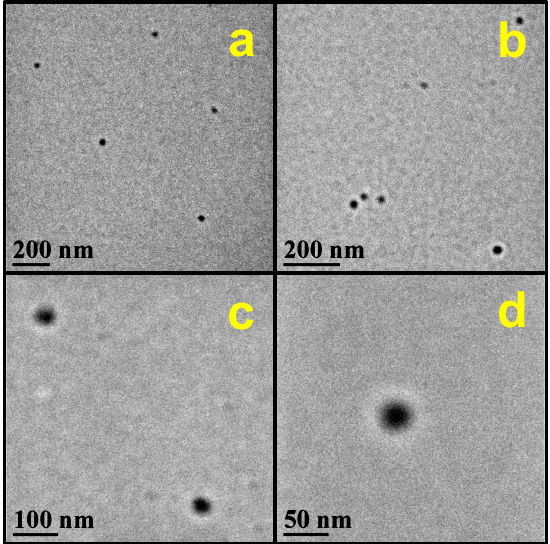
Figure 6. ( a – d ) TEM images of the PDC ( 5 ) micelles from aqueous solutions. TEM samples were